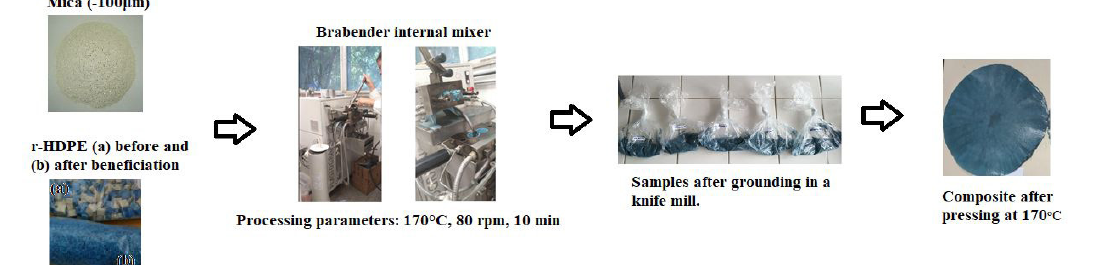
Figure 1. Sketch of the experimental set-up for composite